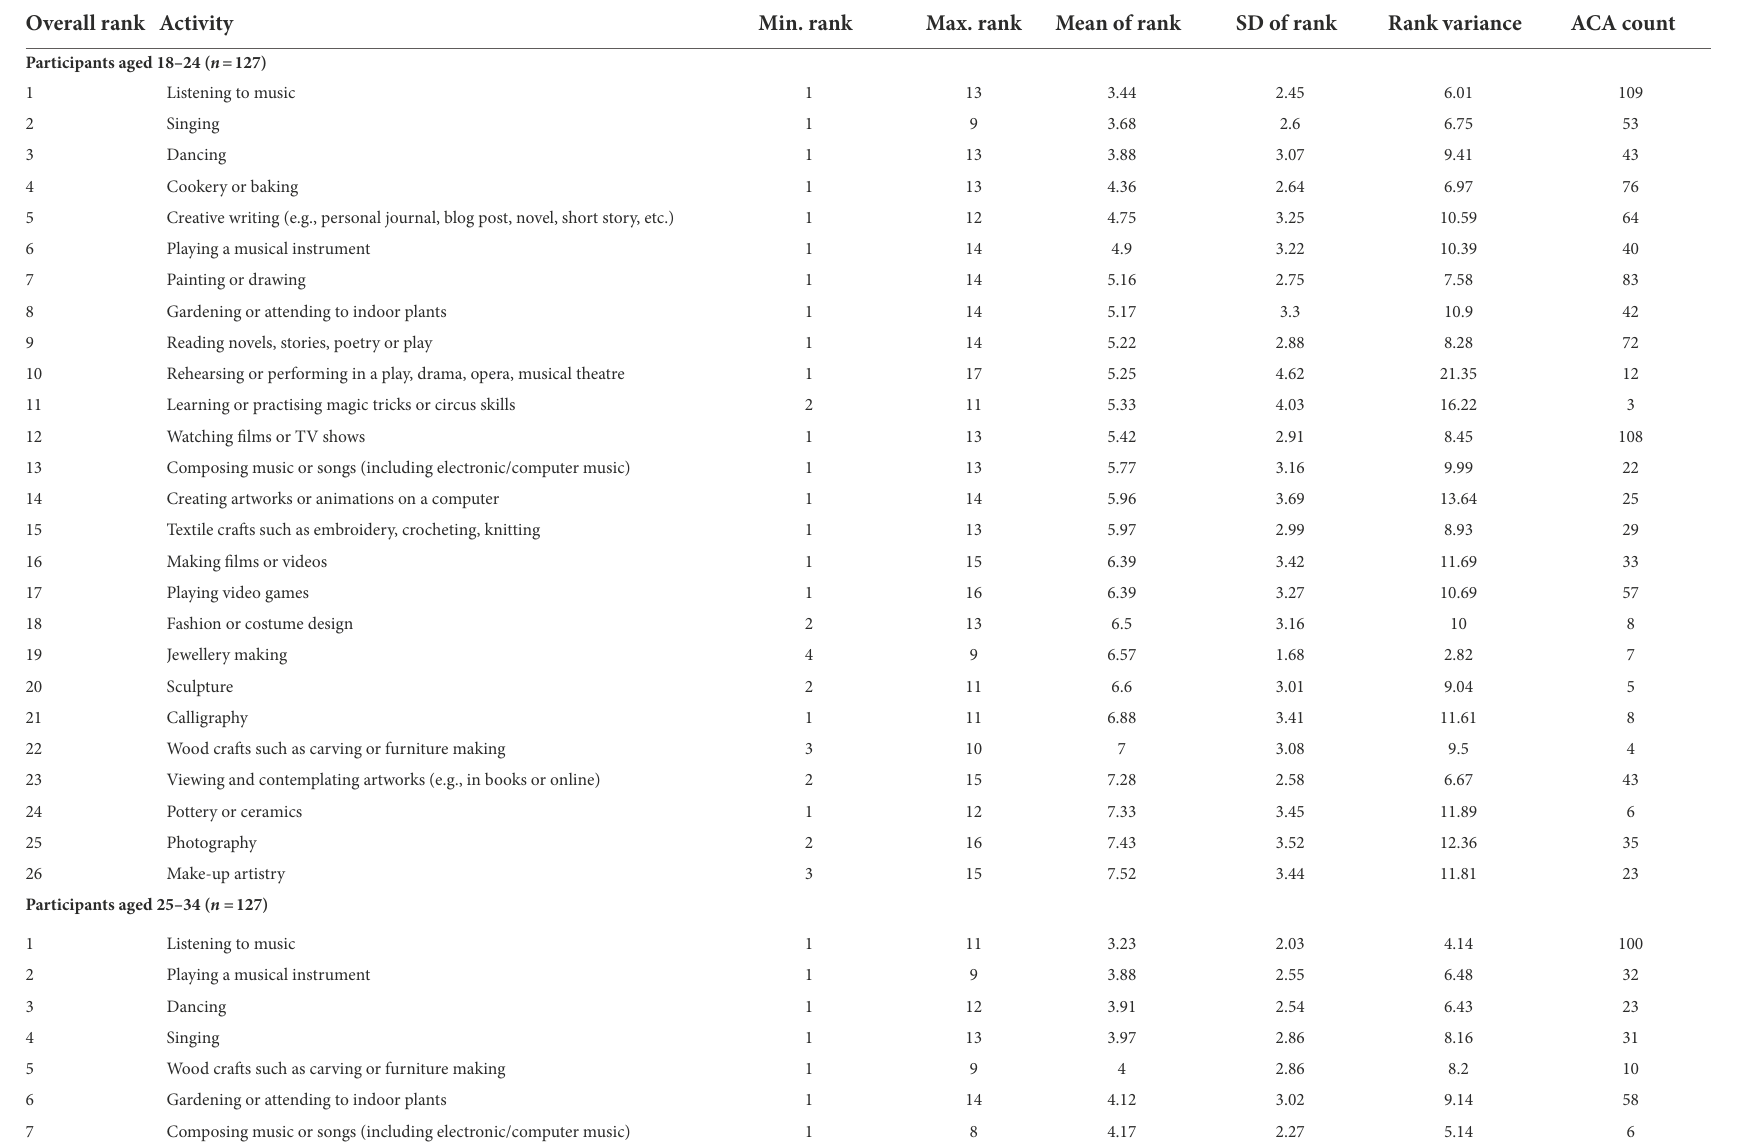
TABLE 1 Ranking of ACAs by reported effectiveness at helping participants to “feel better” during the 2020 COVID-19 lockdowns, split by the four age groups (18–24; 25–34; 35–54; 55+). Overall rank